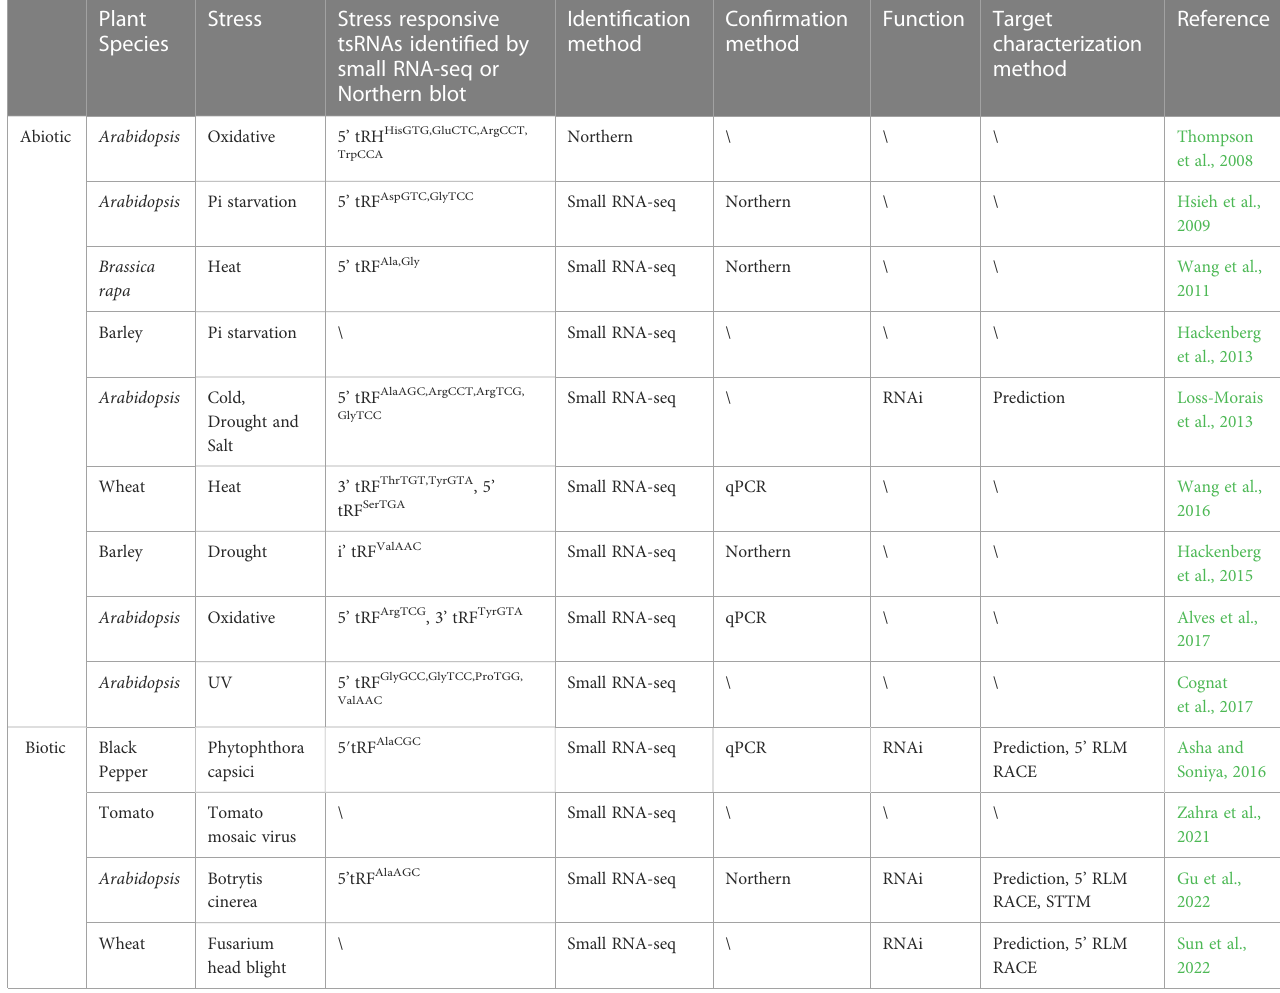
TABLE 1 List of tsRNAs studies in plant biotic and abiotic